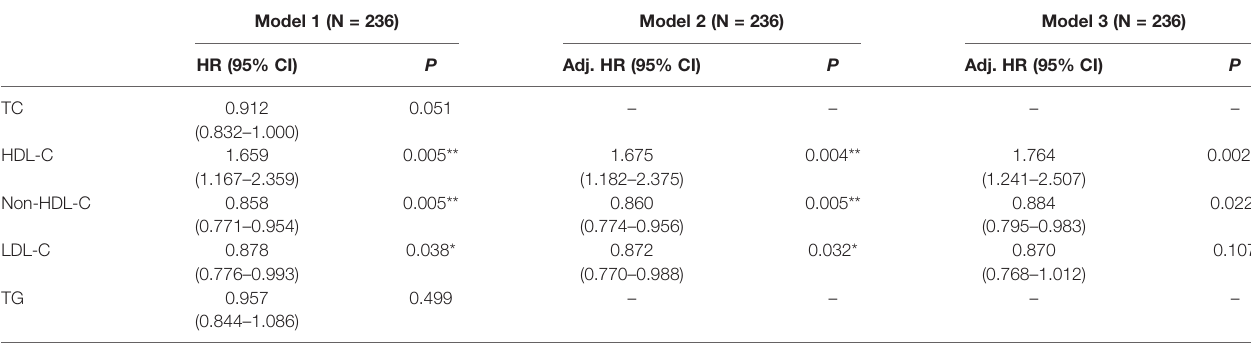
TABLE 6 | Cox proportional hazard models for the associations between lipids after treatment and proteinuria